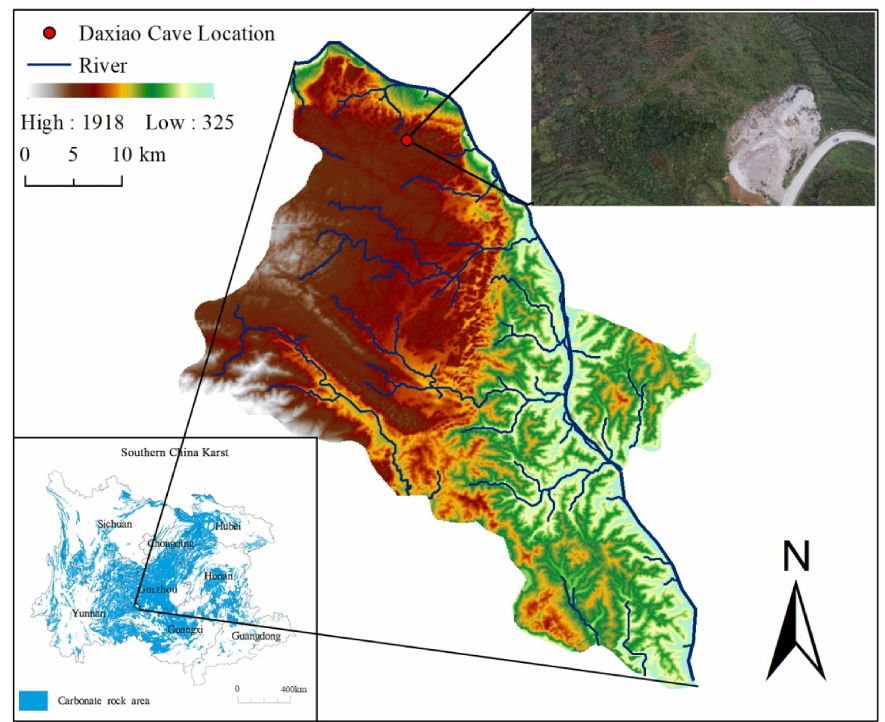
Figure 1. The map of Zhenfeng County showing locations of Daxiao Cave, including an overview of the cave entrance.